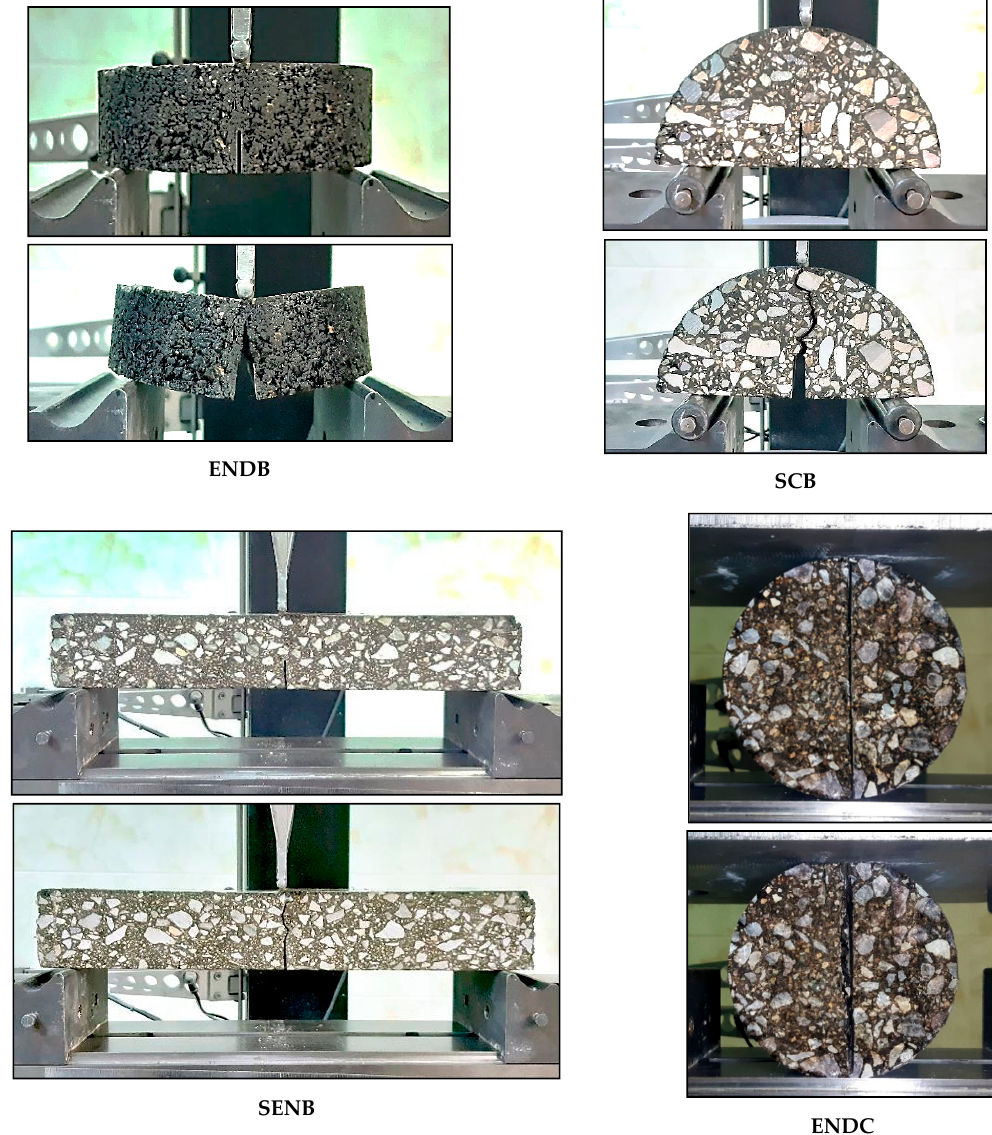
Figure 6. Test setup (before and after failure) for conducting the fracture experiments using different test configurations.